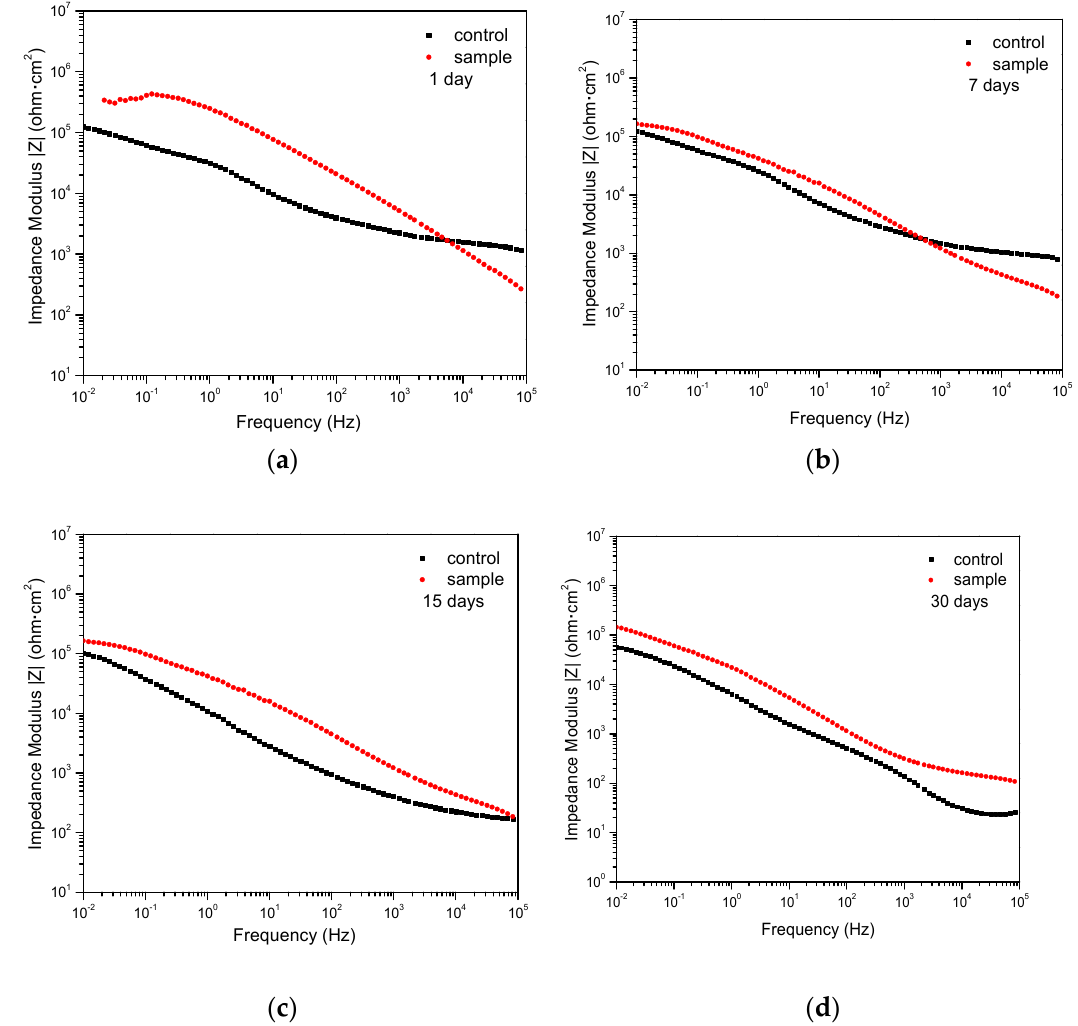
Figure 5. EIS spectrum of the optimally synthesized MoO 3. ( a ) The composite coating sample immersed in 3.5% NaCl solution for 1 day; ( b ) the sample immersed in 3.5% NaCl solution for 7 days; ( c ) the sample immersed in 3.5% NaCl solution for 15 days and ( d ) 30